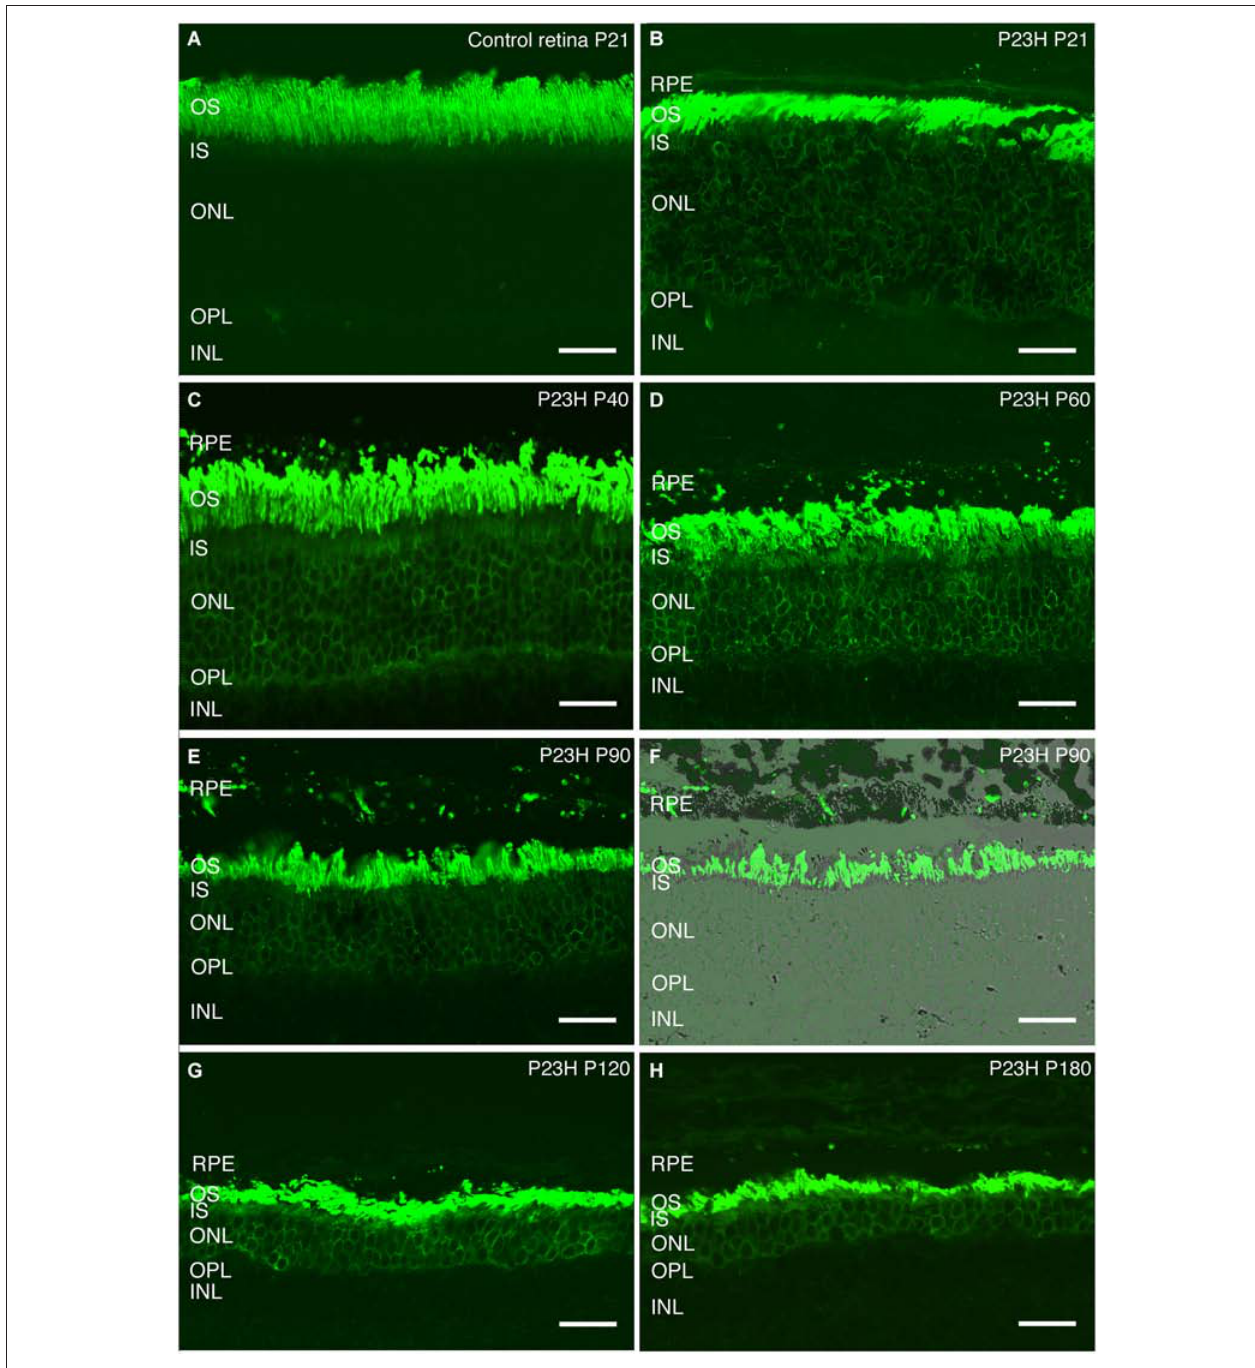
progressive loss of photoreceptor rows, shortening of photoreceptor outer segments and mislocalization of rhodopsin along the cell. RPE: retinal pigment epithelium; OS: outer segments; IS: inner segments; ONL: outer nuclear layer; OPL: outer plexiform layer; INL: inner nuclear layer. Scale bar: 20 µ